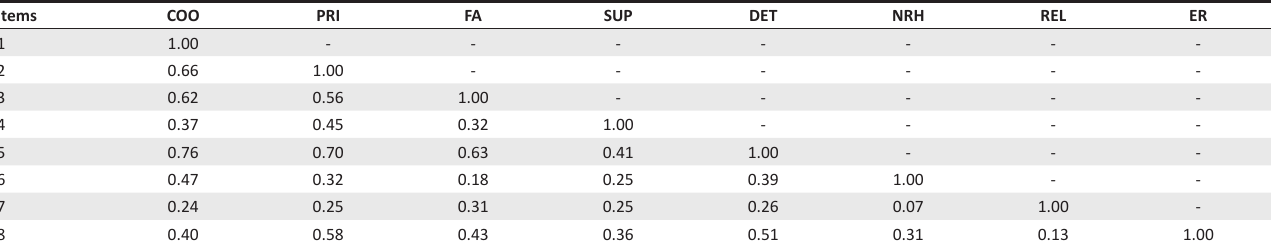
TABLE 5: The Phi matrix (calibration